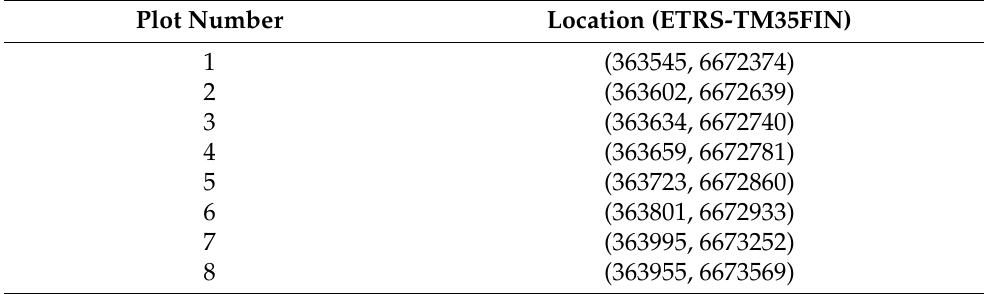
Figure 1. Mosaic composed of orthoimages of examined 8 plots, top row plots 1–4, bottom row plots 5–8. The black stick with white targets that is visible in most images measures 2 m. Table 2. Test plot